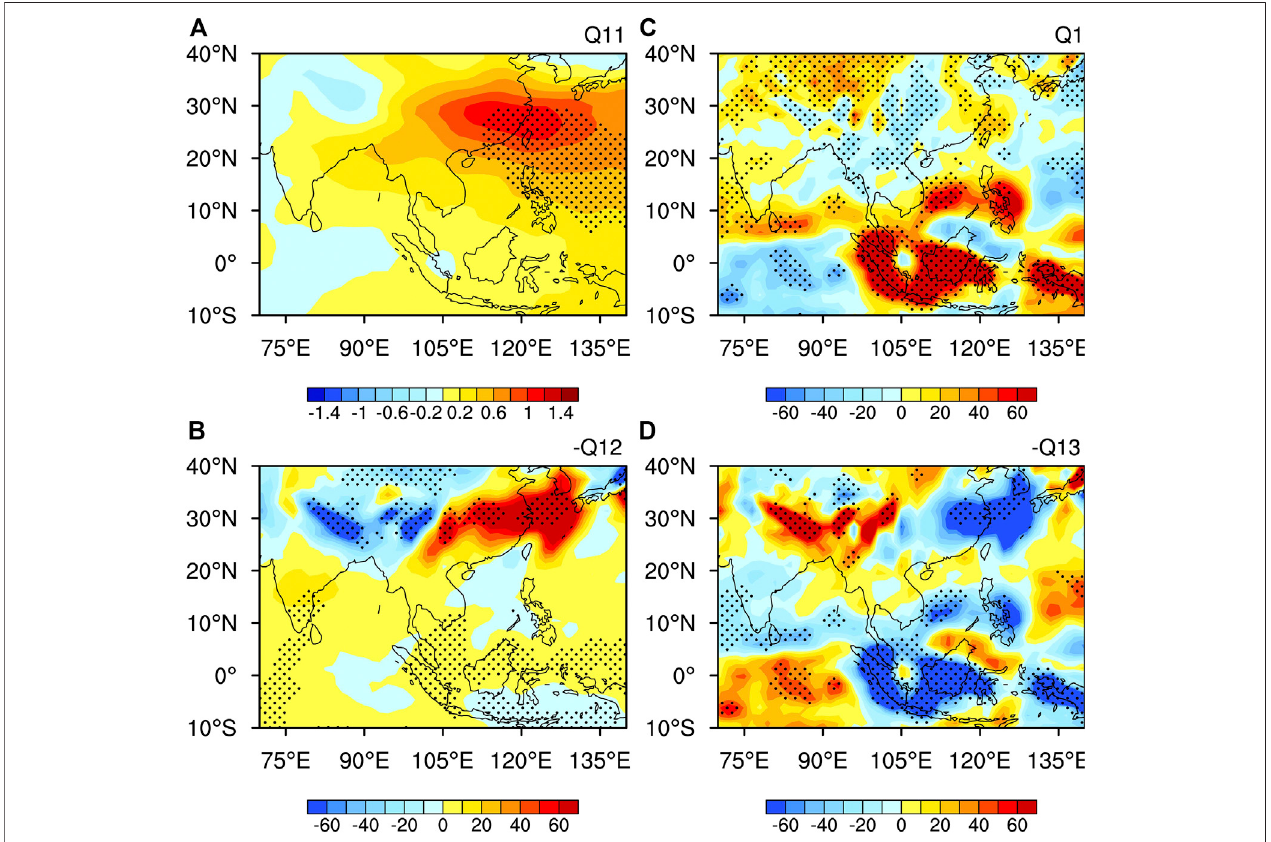
FIGURE 7 | Epochal differences (K) of the thermal forcing terms for the 500 – 200 h · Pa temperature change during November to February ((1994 – 2017) minus (1980 – 1993)). (A) Inter-monthlytemperaturechangerate(Q11). (B) Temperatureadvectionrate( − Q12). (C) Diabaticheatingrate(Q1). (D) Adiabaticheatingrate( − Q13). The stippled areas denote the difference signi fi cant at the 95% con fi dence level.